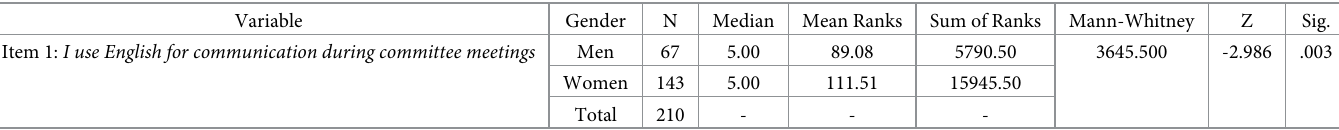
Table 2. Mann-Whitney test.